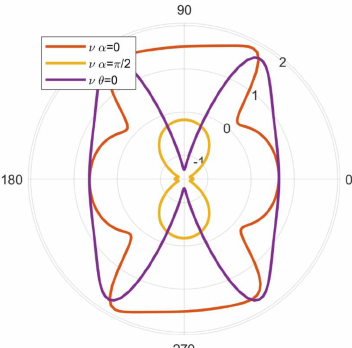
Figure A1. Benchmarks to Rovati (2004, their Fig. 4) for monoclinic cesium dihydrogen phosphate. Note the extreme auxeticity (negative Poisson’s ratio) shown by this material.